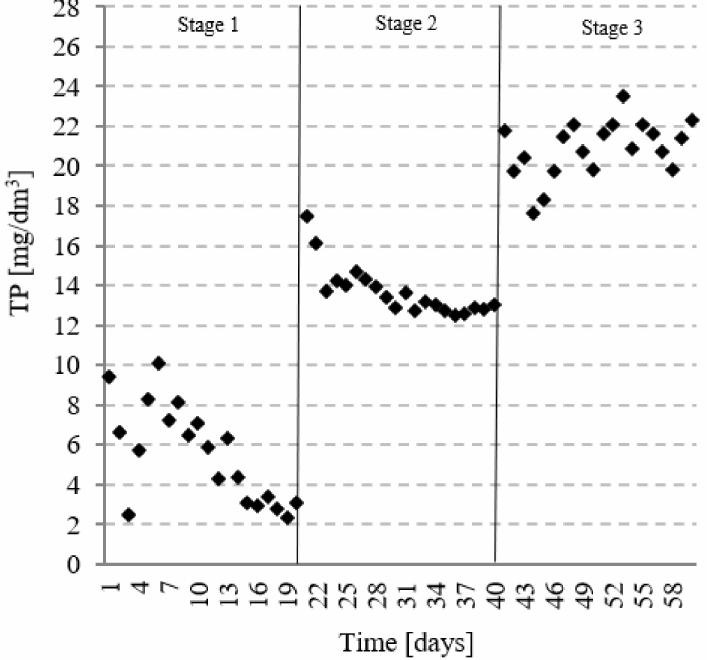
Figure 10. Changes in the total phosphorus concentration in the treated e ffl